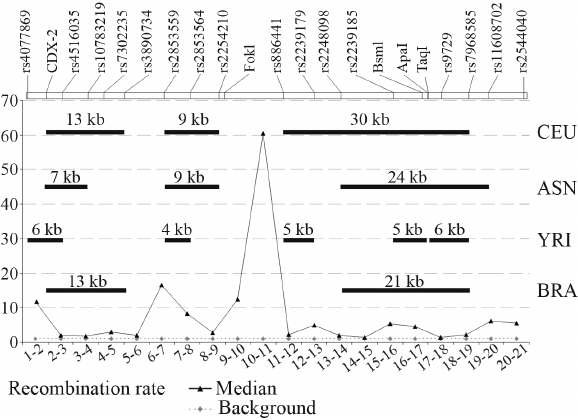
Figure 1 - Distribution of the haplotype blocks among populations (ASN – East-Asian individuals, CEU – northern and western European origin, YRI – Yoruba individuals from Ibadan, Nigeria) and estimates of the pairwise recombination rates in the Brazilian (BRZ) population. Horizon- tal bars represent the extent of the haplotype blocks in each population. Values on the y-axis are the median of the factor by which the recombina- tionratebetweenloci(x-axis)exceedsthebackgroundrecombinationrate. The SNPs rs4077869, rs2239185, rs7302235 and rs4516053 are shown to facilitate location since they were excluded from population